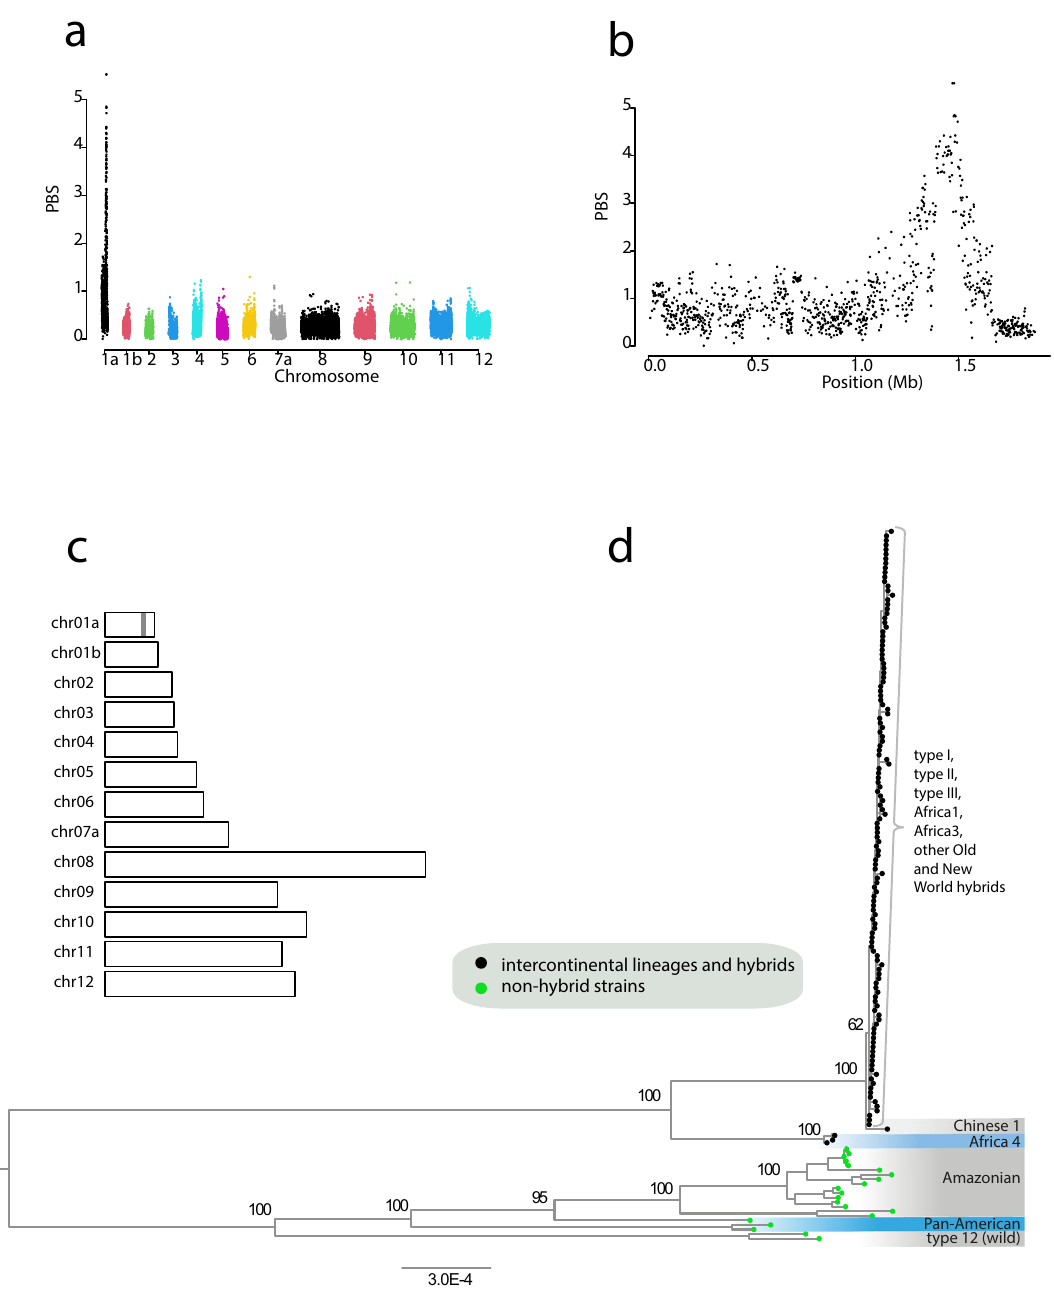
Fig. 4 | Outlier region under selection in intercontinental lineages and hybrid strains. a The Manhattan plot shows the genome-wide distribution of popu- lation branch statistic (PBS) for each 50-SNP sliding window using the clone- censoreddataset( n = 71). b ThisisazoomonPBSobtainedforchromosome1a. c Genomic positions of variants speci fi c to intercontinental lineages and hybrid strains ( n = 310) from the clone-censored dataset are indicated by grey